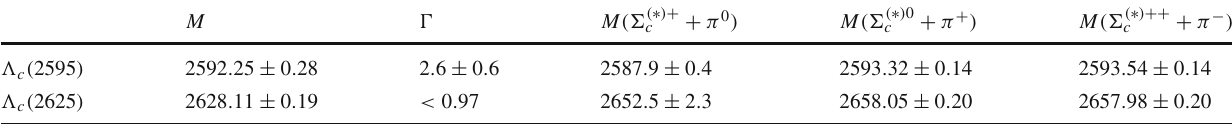
M ((cid:2) c + π + + π − ) = 2565 . 60 ± 0 . 14 MeV and M ((cid:2) c + π 0 + π 0 ) ( ∗ ) c resonances, are